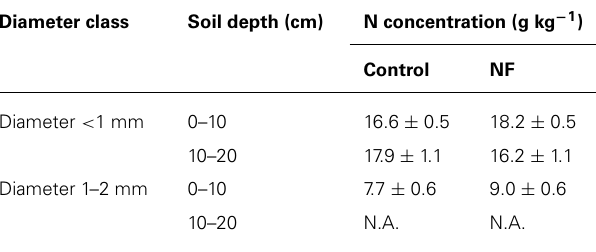
Table 7 | N concentrations in fine roots of sugi in control and nitrogen-fertilized (NF) plots. Diameter